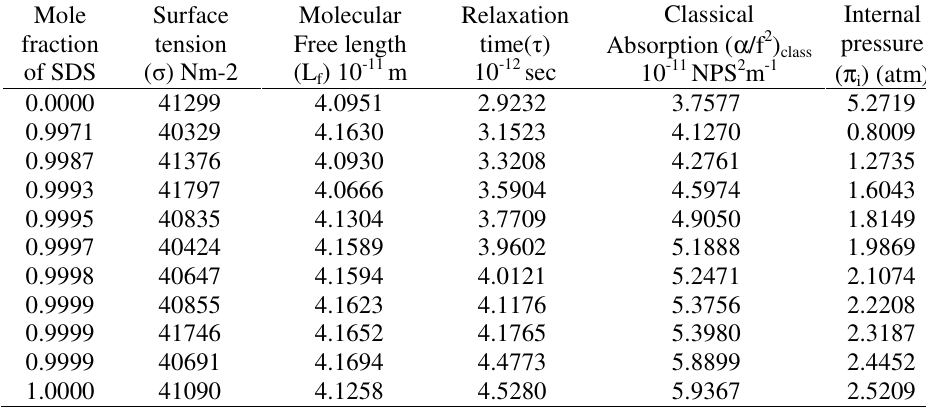
Table 4. Experimental values of surface tension ( σ ), free length (L absorption coefficient ( α /f 2 ) (0.5 N) in poly (vinyl alcohol) solution at